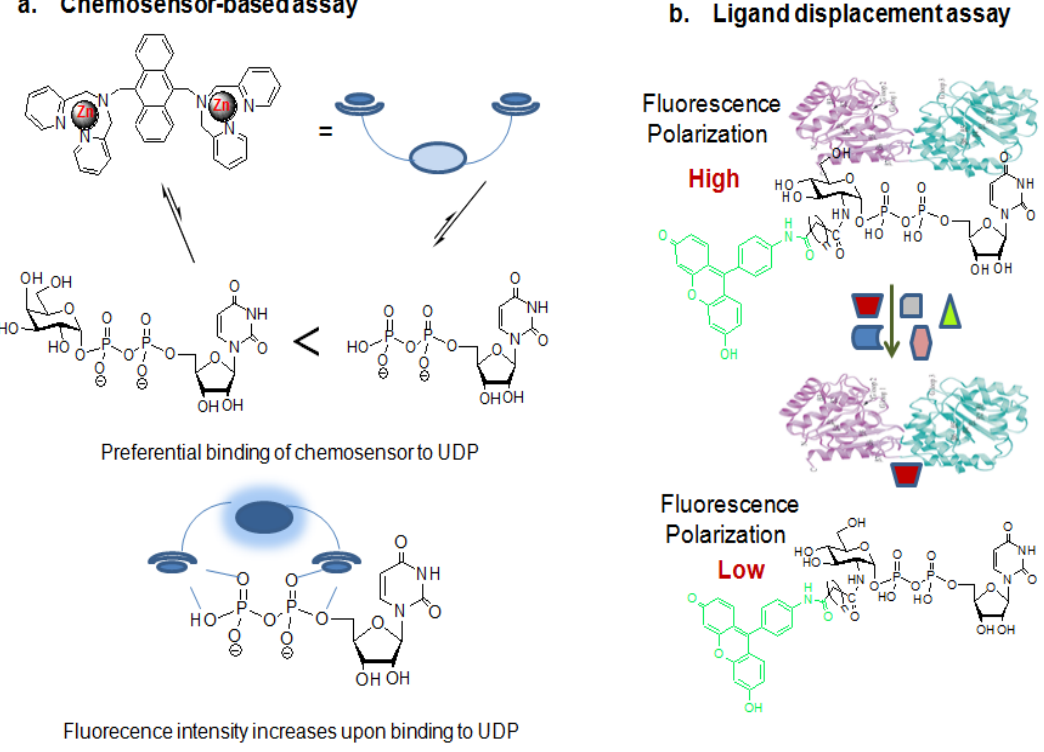
Figure 12. Strategies developed for OGT activity assay and high-throughput